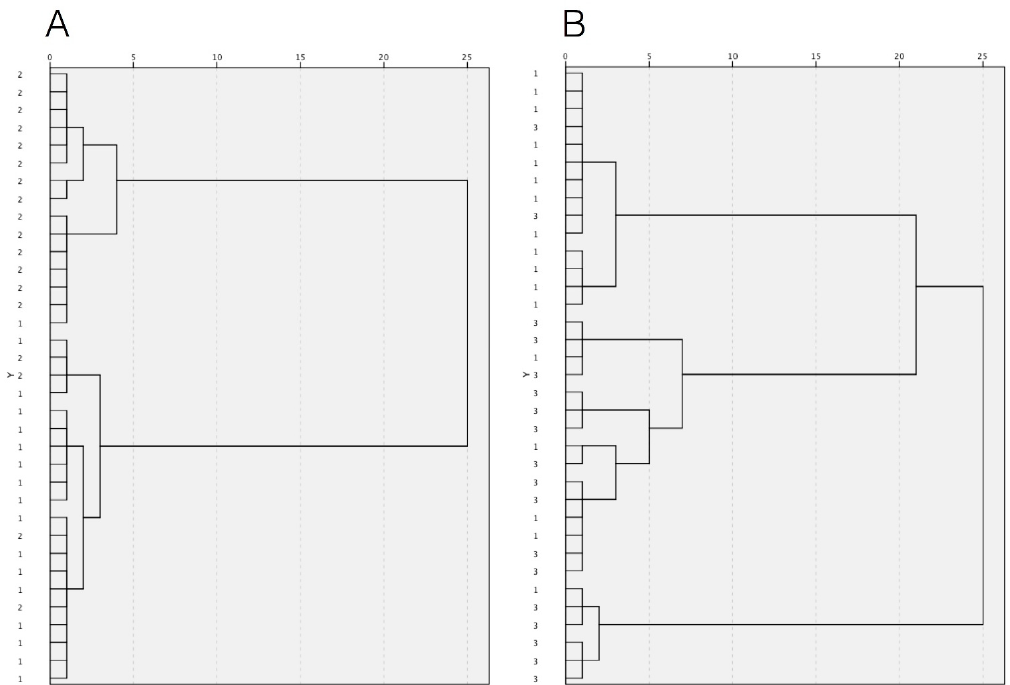
Figure 1. The dendrograms show the results of HCA based on ion distribution in GCF: ( A ) clustering of subjects with untreated severe periodontitis (group 2) and periodontally healthy controls (group 1) and ( B ) clustering of subjects with treated severe periodontitis (group 3) and periodontally healthy controls (group 1). The same chemical elements in saliva demonstrated a poor clustering ability (Figure 2): untreated periodontitis patients were not effectively discriminated from healthy sub- jects (Figure 2A) and treated periodontitis were grouped together with healthy controls (Figure 2B).